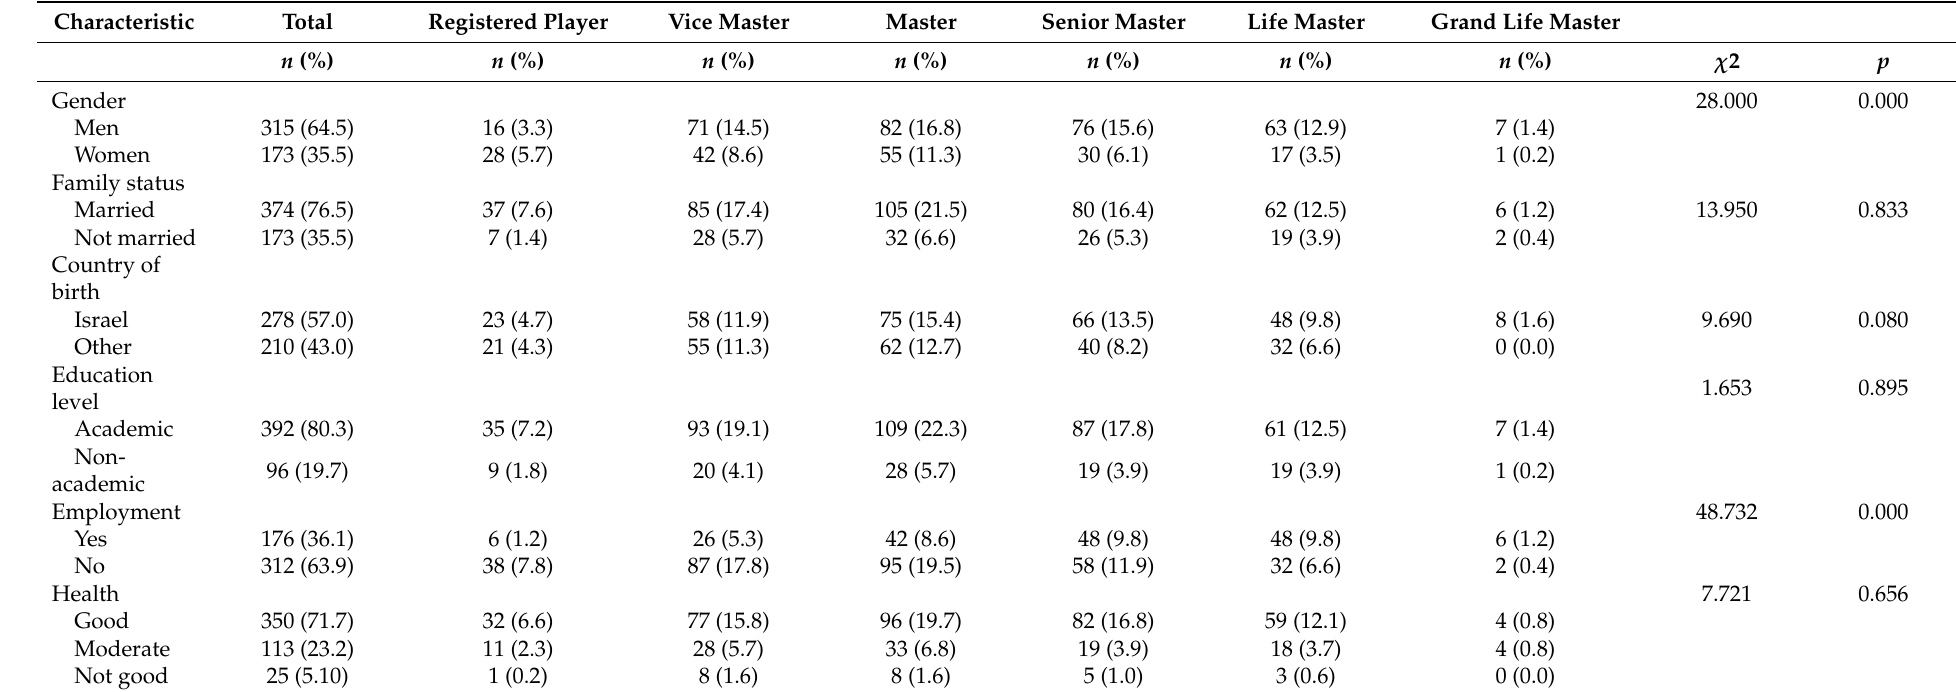
Table 1. Player-level category by demographic